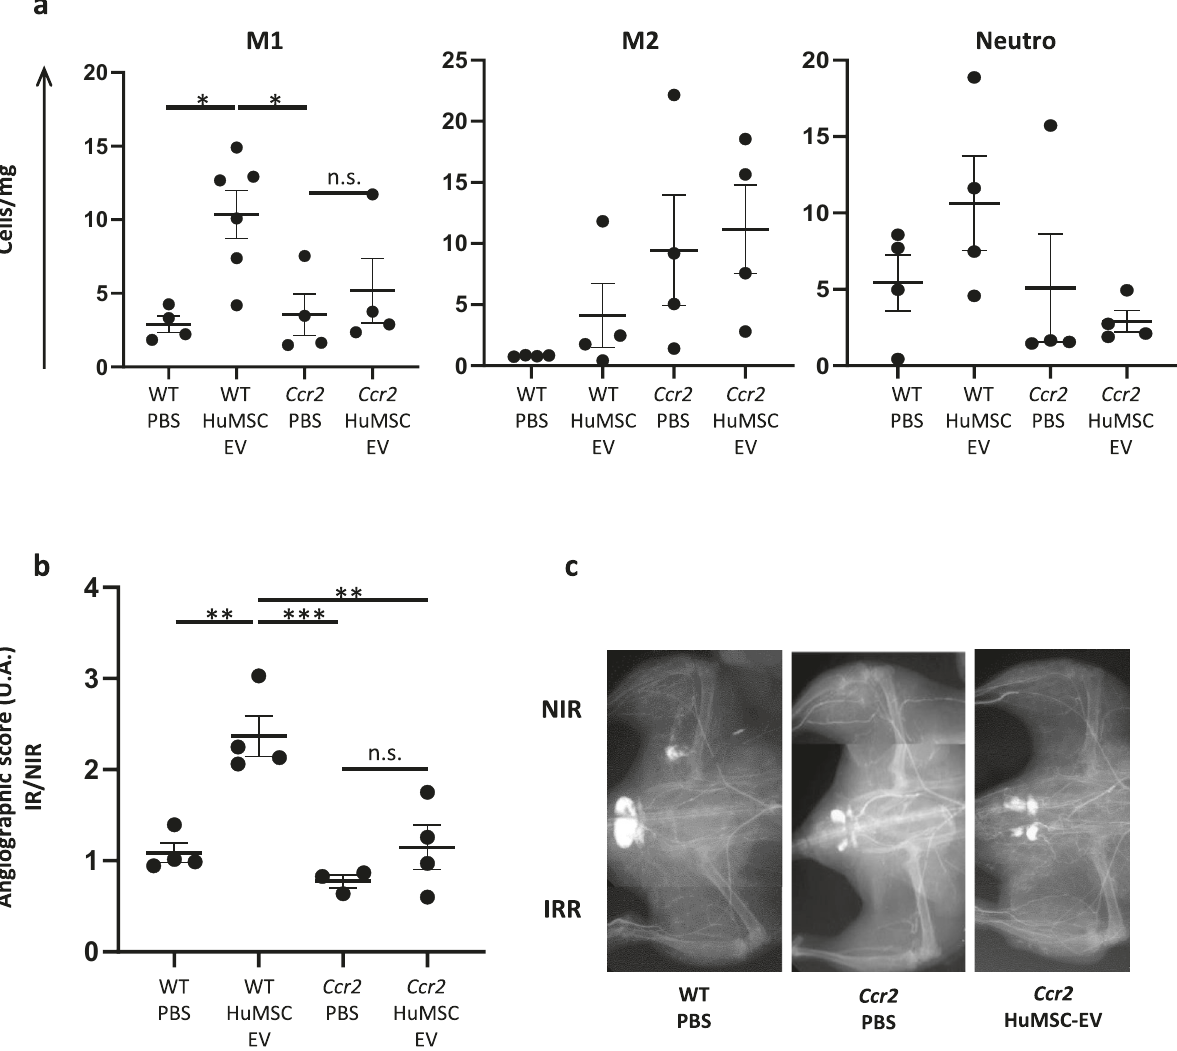
Fig. 6 CCR2 de fi ciency abrogates the effect of HuMSC-EV on monocyte recruitment and neovascularization process. a Quantitative analysis of cell counts for M1-like macrophages (CD11b + Ly6G-F4/80 + CD64 + MHCII + ) (left), M2-like macrophages (CD11b + Ly6G − F4/ 80 + CD64 + MHCII − ) (middle) and neutrophils (right) in irradiated gastrocnemius, at day 21 post-irradiation. b Quantitative analysis of microangiography at day 28 post-irradiation, represented as the ratio of the angiographic score of the irradiated limb to the angiographic score of non-irradiated limb. c Representative pictures of microangiography of the non-irradiated limb (NIR, top) and irradiated limb (IR, bottom), in WT-PBS (left) and Ccr2-PBS (middle), and Ccr2-HuMSC-EV (right). Data are means ± SEM ( n = 4 animals/group); * P < 0.05, ** P < 0.01, *** P < 0.001; n.s., not signi fi cant; one-way ANOVA followed by Tukey ’ s